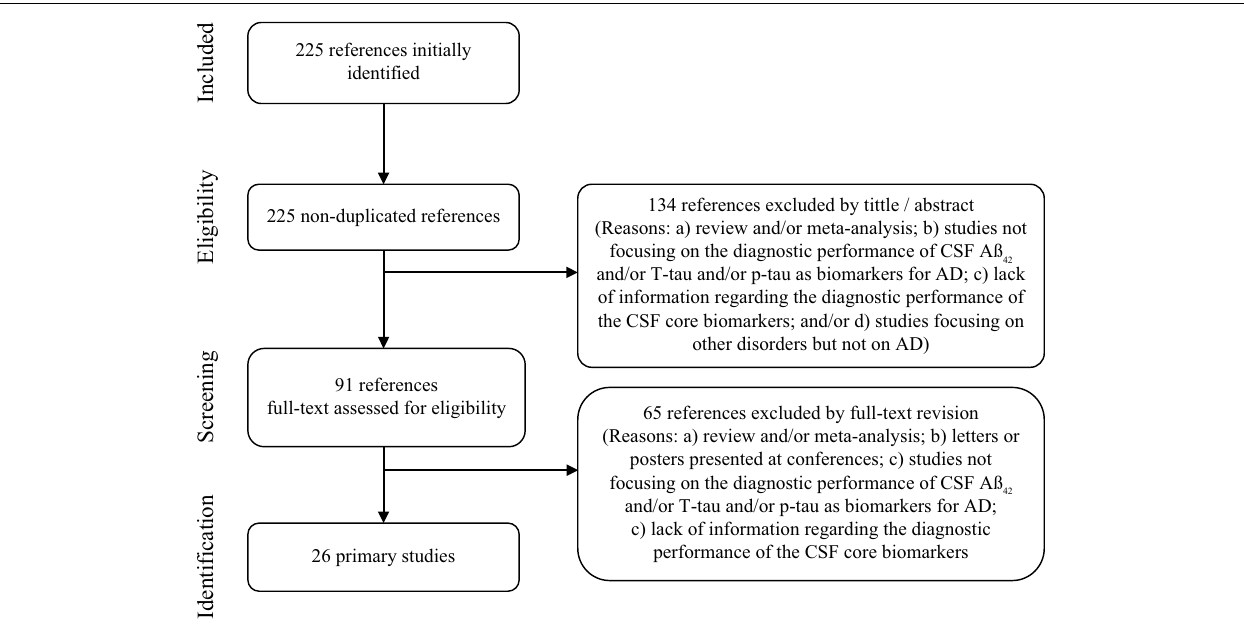
values provided in the systematic reviews with meta-analysis and primary